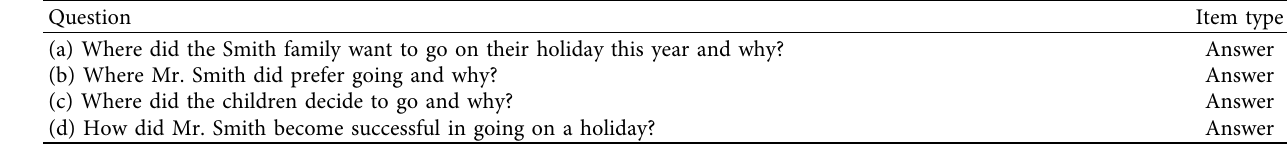
Table 2: Sample question of reading comprehension.